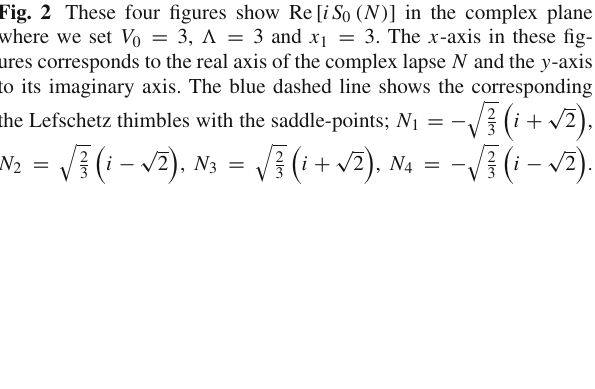
Fig. 2 These four figures show Re[ iS 0 ( N ) ] in the complex plane where we set V 0 = 3, (cid:6) = 3 and x 1 = 3. The x -axis in these fig- ures corresponds to the real axis of the complex lapse N and the y -axis to its imaginary axis. The blue dashed line shows the corresponding the Lefschetz thimbles with the saddle-points; N 1 = −